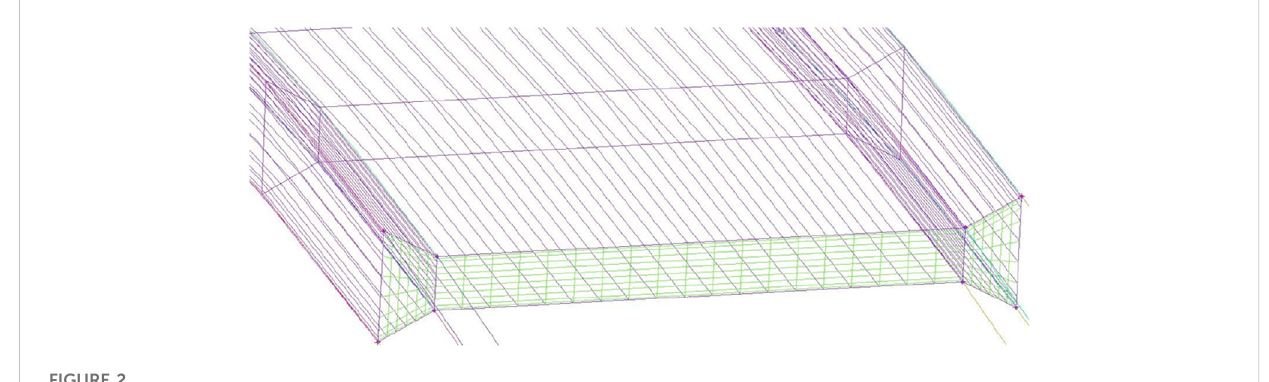
FIGURE 2 Mesh details at wear-ring.